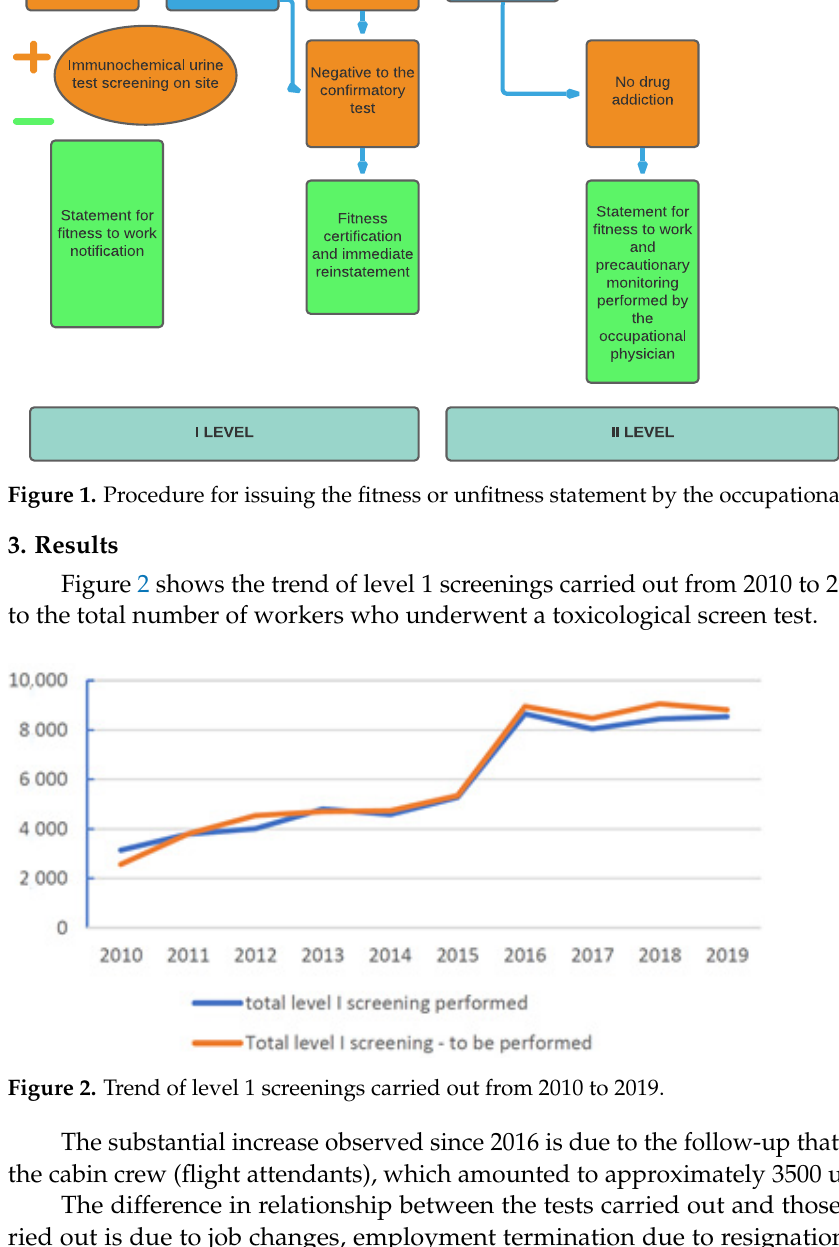
Figure 2. Trend of level 1 screenings carried out from 2010 to 2019.